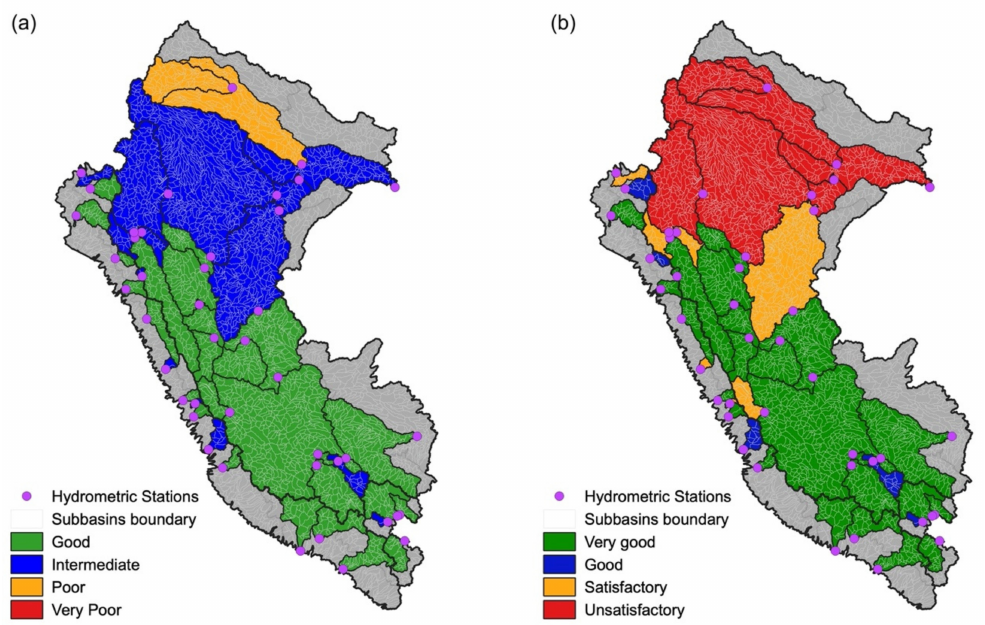
Figure 9. Qualitative ratings of streamflow simulation result at 43 hydrometric stations across the study area, based on ( a ) KGE and ( b ) NSE sqrt